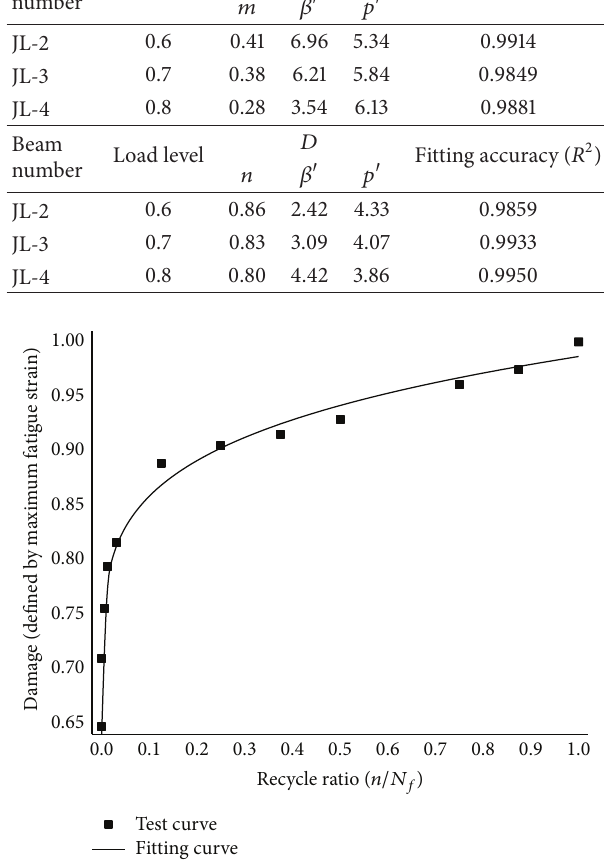
Figure 6: Damage result of JL-2 based on maximum fatigue strain.